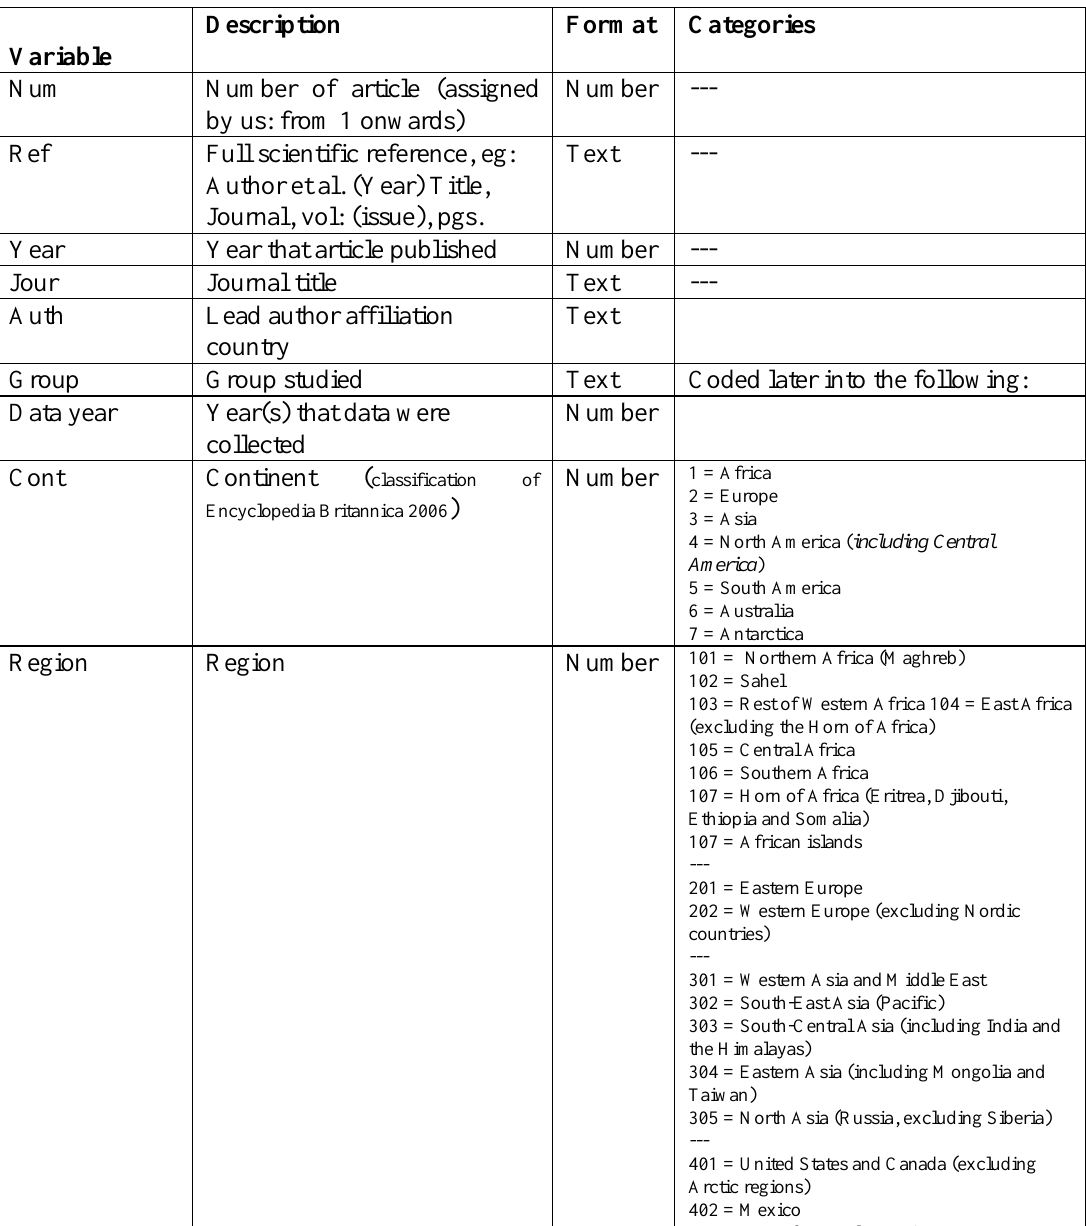
Table A1. Descriptive